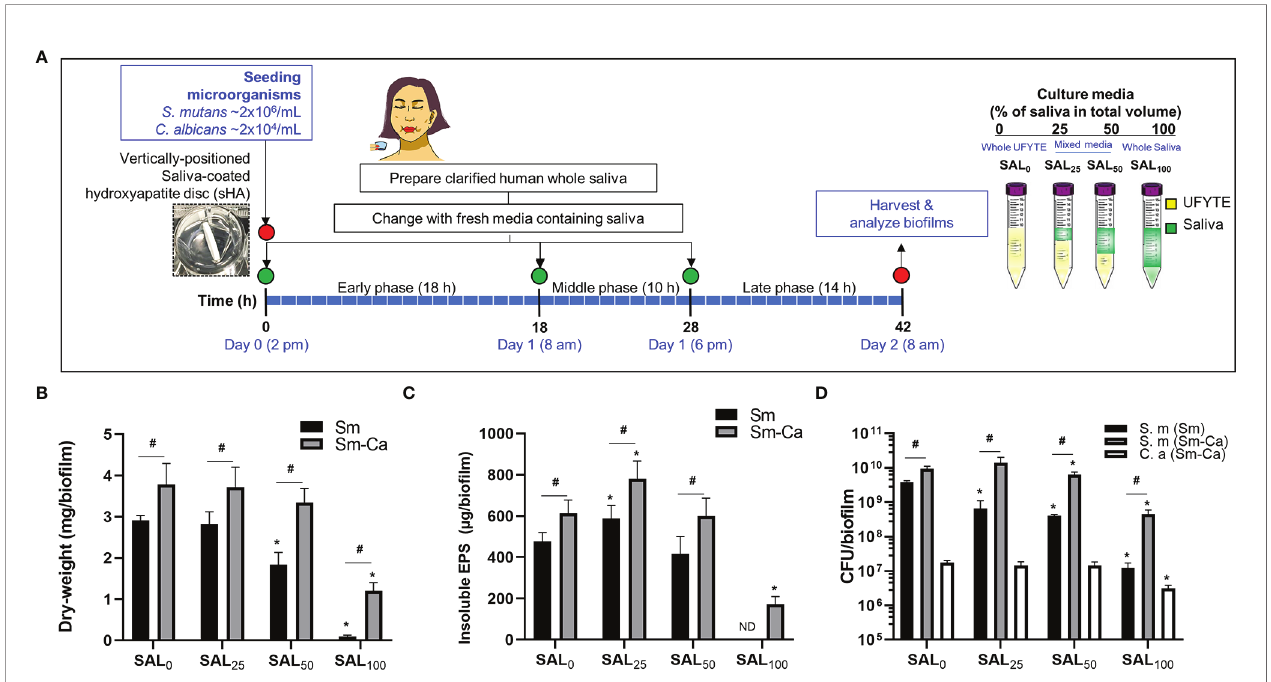
FIGURE 1 | Microbiological and biochemical properties of Sm and Sm-Ca bio fi lms in saliva contained media (0 – 100%). (A) Bio fi lm experimental design and composition of culture media. (B) Biomass (Dry-weight) of bio fi lms. (C) Amounts of insoluble polysaccharides (EPS) in bio fi lms. The biomass of Sm bio fi lm in SAL 100 was below the detection limit, thus it was not able to measure the content of EPS-glucans in Sm cultured in SAL 100 . (D) CFU of S. mutans and C. albicans in Sm and Sm-Ca bio fi lms at fi nal phases (42 h). Dry weight, EPS, and CFU experiments were performed (n>3) separately for each donor saliva, and then the average values were calculated. Asterisk indicates that the p -values are signi fi cantly different from SAL 0 (whole UFYTE) (ANOVA with Dunnett; * P < 0.05). Hash indicates that the p -values are signi fi cantly different between two groups (Student ’ s t -test; # P < 0.05). ND indicates not